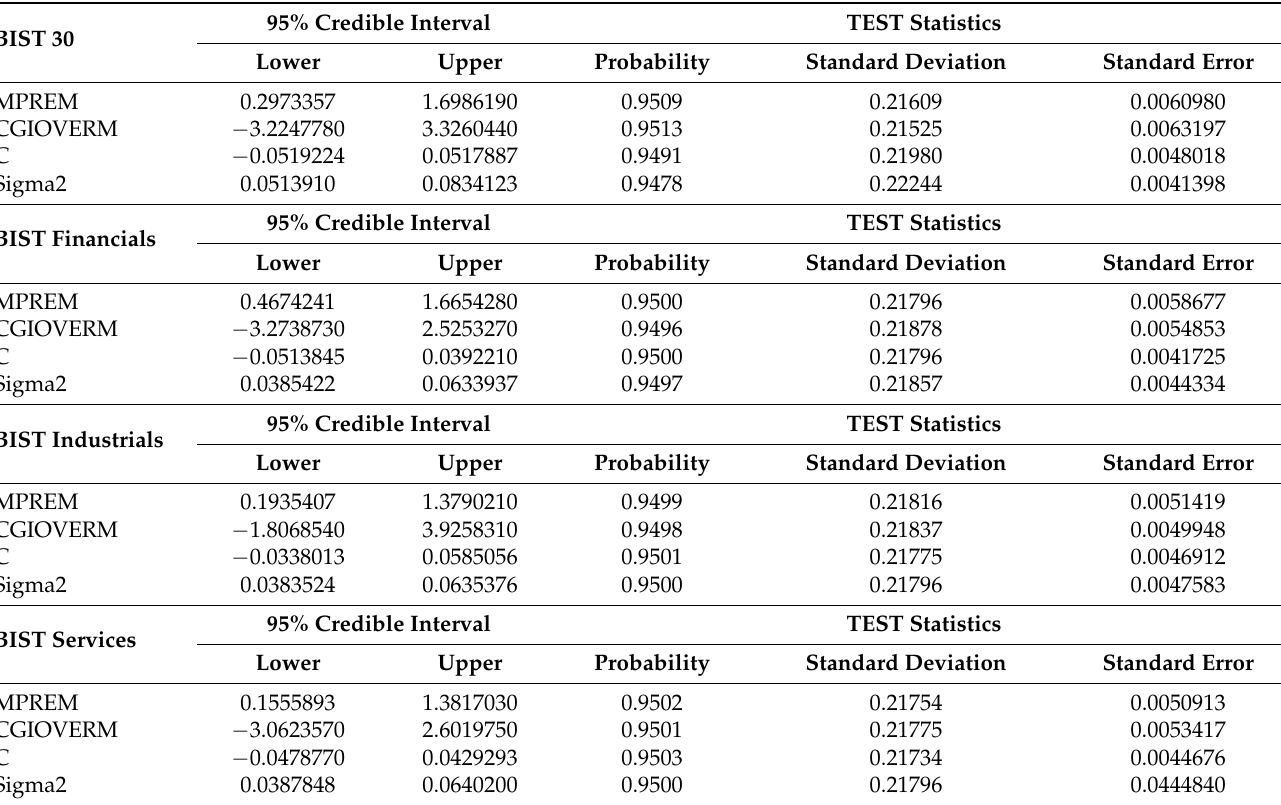
Table 9. Credible interval hypothesis